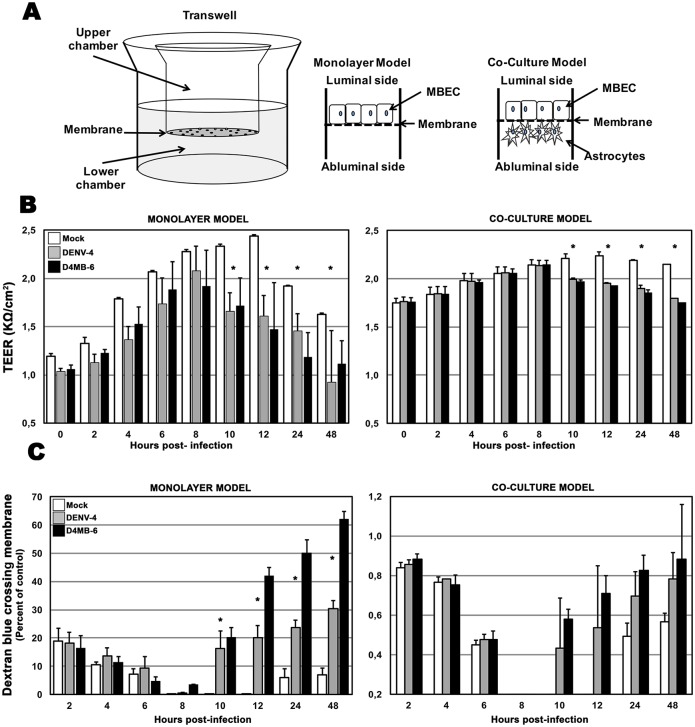
Scheme barrier models and evaluation of TEER and permeability assay in each models.(A). Endothelial barrier model scheme. Transwell inserts were used to establish the two barrier models. The first one (Monolayer model) consisted in MBEC cultured on the luminal side of the membrane (upper side) for four days until monolayer reaches TEER values between 1 to 1,5 kΩ. For establishing the second one barrier model (co-culture model), the glial cells were seed on the abluminal side inverting the insert for three days, then it was flipped to the right position before seeding the MBEC in the luminal side. (B). Transendothelial electrical resistance. MBEC in each barrier model were infected or treated with mock inoculum. Since 10 h p.i. there was a significant reduction in TEER in DENV-4 and D4MB-6 infected compared with mock-inoculated barrier models. This TEER loss was sustained up to 48 h p.i. (p<0.05, Kruskal-Wallis and Bonferroni tests), however, TEER changes were less drastic in MBEC-astrocytes co-culture with regard to monolayer barrier model. (C). Permeability assay. Using the same culture and infection protocols described above, dextran blue (DB) permeability assays were performed. DB was added in the insert’s upper chamber and at each time point; the lower chamber medium culture was collected to quantify the DB pass through by spectrophotometry. Since 10 to 48 h p.i. the infection with both virus strains induced a significant increase in lower chamber DB concentration coinciding with TEER loss. Barrier damage and DB quantified in the lower medium of MBEC-astrocytes co-culture were too low (between 0,2 to 1,2%) indicating a protective role of astrocytes. Data shown are mean of TEER or DB percentage from triplicates of two independent cultures and SD.